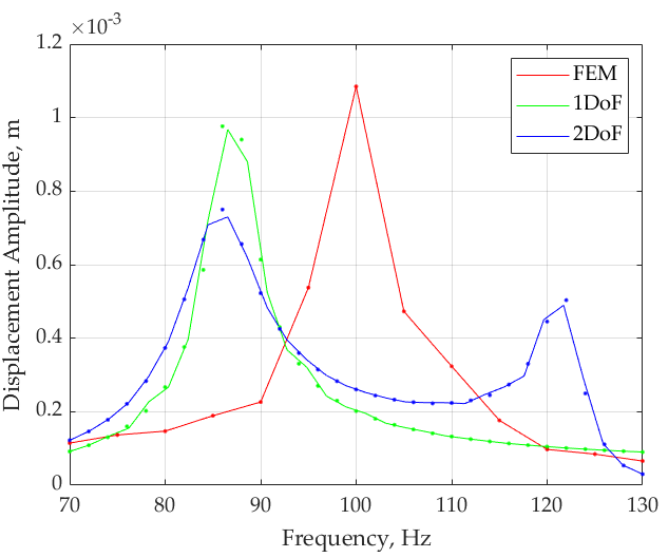
Figure 17. The displacement amplitude as a function of the frequency of the levitated magnet was calculated by the 1-DoF and 2-DoF kinematic chain models and the FEM model.